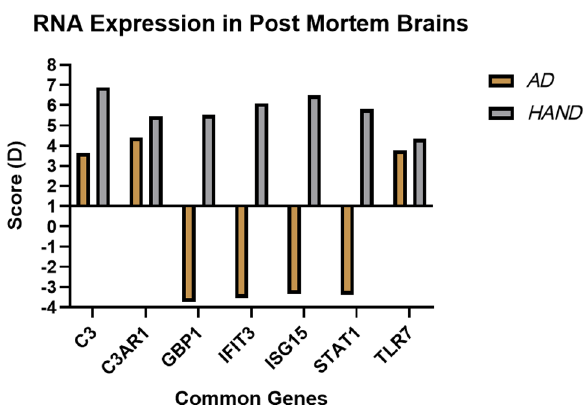
Figure 11. Dysregulated RNA in AD and HAND. This graph represents the dysregulation of RNA expression in HAND and AD. The results were derived from the SAM analysis. Two unpaired analysis was done independently “Control vs AD” and “Control vs HAND”. The Score (D) represented negative values which represent down-regulation of RNA and positive values represent upregulation in RNA expression. The dark yellow represents “AD” data and the grey represents “HAND”. The common genes that were derived from the SAM Analysis results and submitted through DAVID for the gene ontology